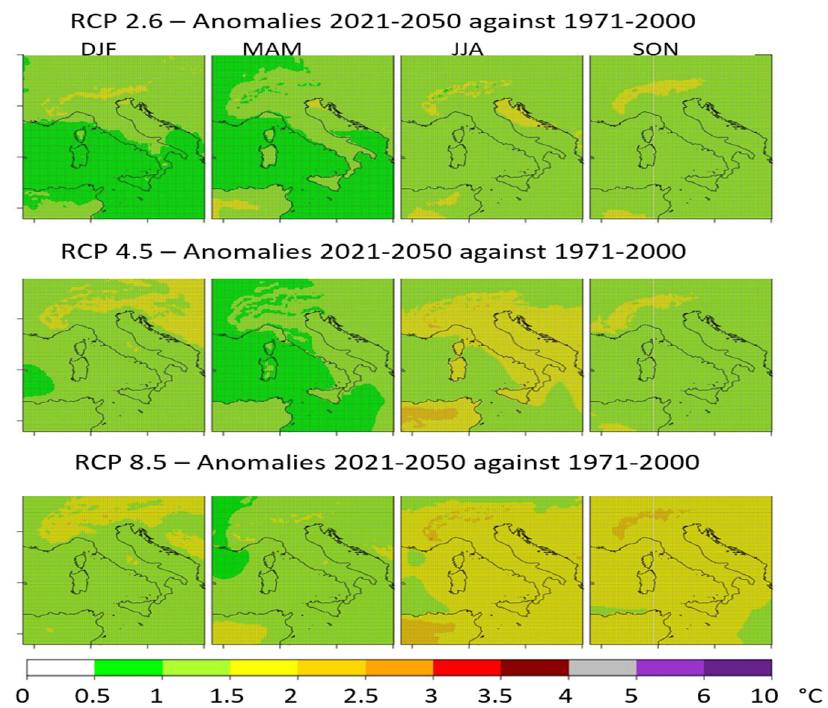
Figure 3. Seasonal Mean Surface temperature anomalies (°C) expected by 2021–2050 (DJF, MAM, JJA, SON, respectively from first to fourth column), against the reference period 1971–2000 gathered by Euro-CORDEX ensemble models, under RCP 2.6 (top), RCP 4.5 (center), RCP 8.5 (bottom) configurations.